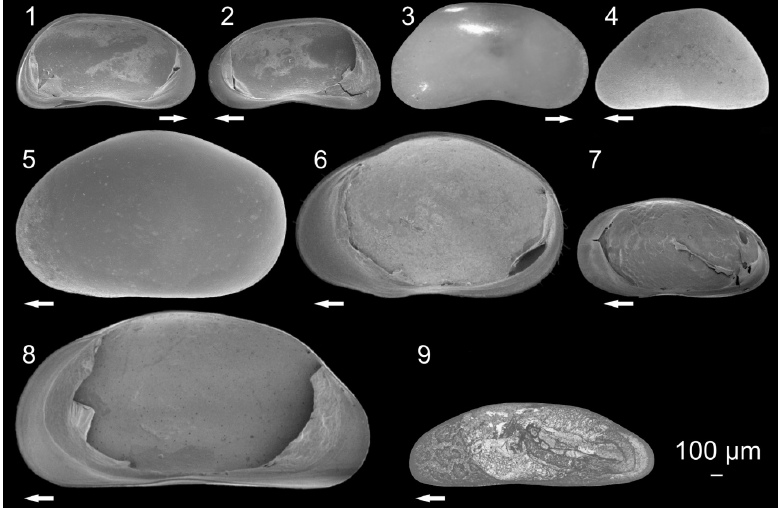
Figure 4. Pictures of ostracodes from Lake Ohrid: Candona marginatoides ( 1 ) Left valve (LV), internal view, female; C. marginatoides ( 2 ) Right valve (RV), internal view, female; Candona bimucronata ( 3 ) RV, external view, female; Candona expansa ( 4 ) LV, external view, female; Eucypris virens ( 5 ) LV, external view, female; E. virens ( 6 ) RV, internal view, female; Bradleystrandesia reticulata ( 7 ) RV, internal view, female; Eucypris sp. ( 8 ) RV, internal view, female; Dolerocypris sinensis ( 9 ) LV, external view, female. Arrows point to anterior part of valves (modified from